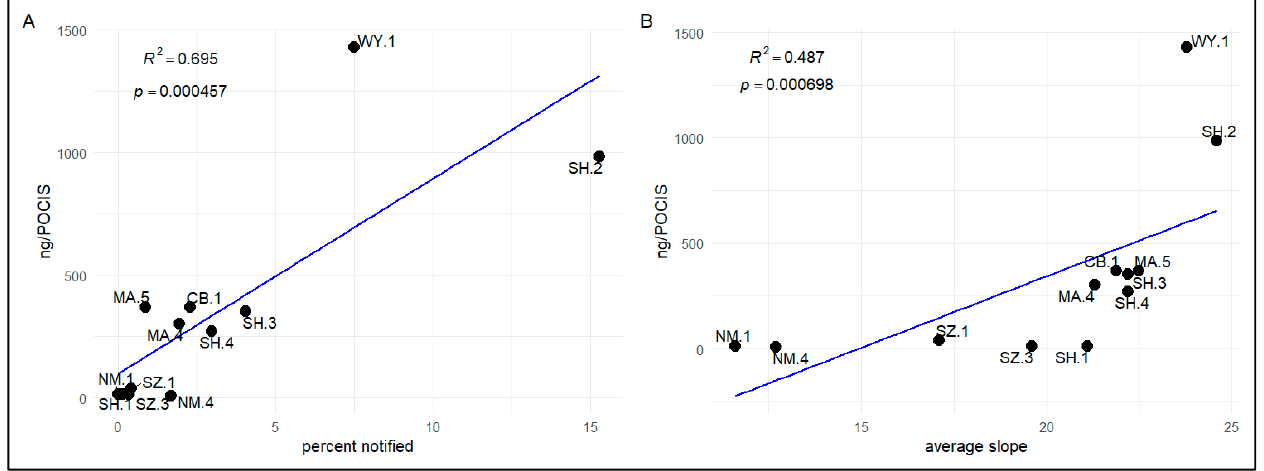
Figure 6. Linear regression indicated that total herbicide load captured in the POCIS was positively correlated with ( A ) active aerial herbicide notifications during deployment window (R 2 = 0.695, p ≤ 0.001) and ( B ) average watershed slope (R 2 = 0.487, p ≤ 0.001). Formulae and results in plots reflect calculations with both variables square root transformed to meet regression assumptions.